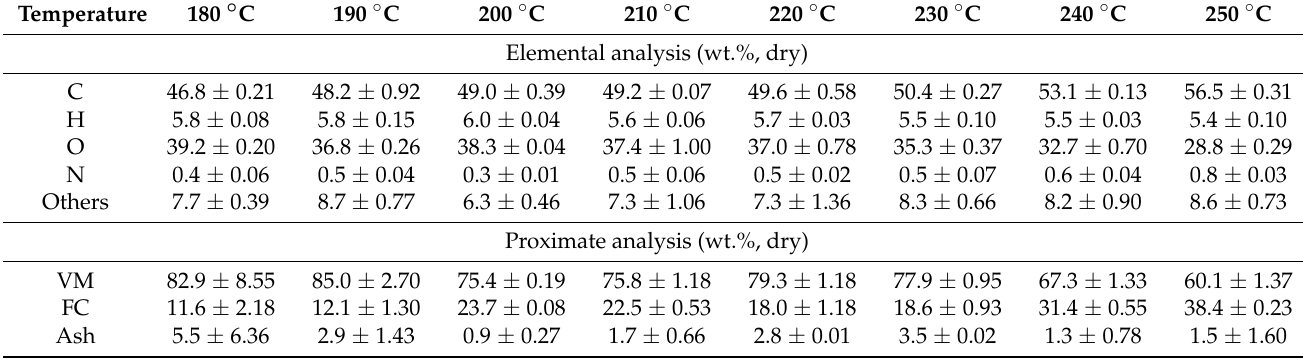
Table 3. Elemental and proximate analysis of EFB according to reaction temperature (EFB:water = 1:16).